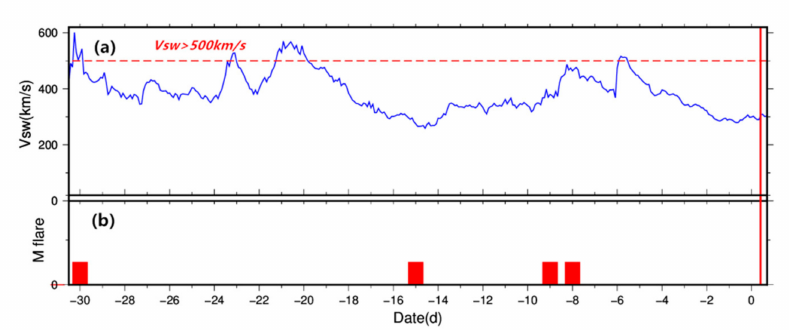
Figure 4. Wind plasma speed (Vsw) and solar flare indices in the one month preceding the Lushan earthquakes: ( a ) the time series of Vsw, and ( b ) the occurrence of M-level